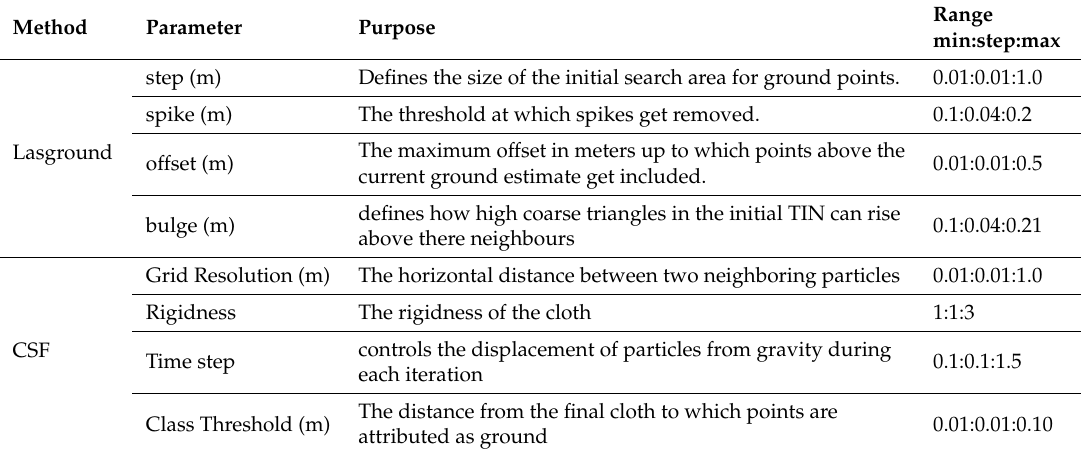
Table 2. The parameter ranges used for the optimisation of the two ground